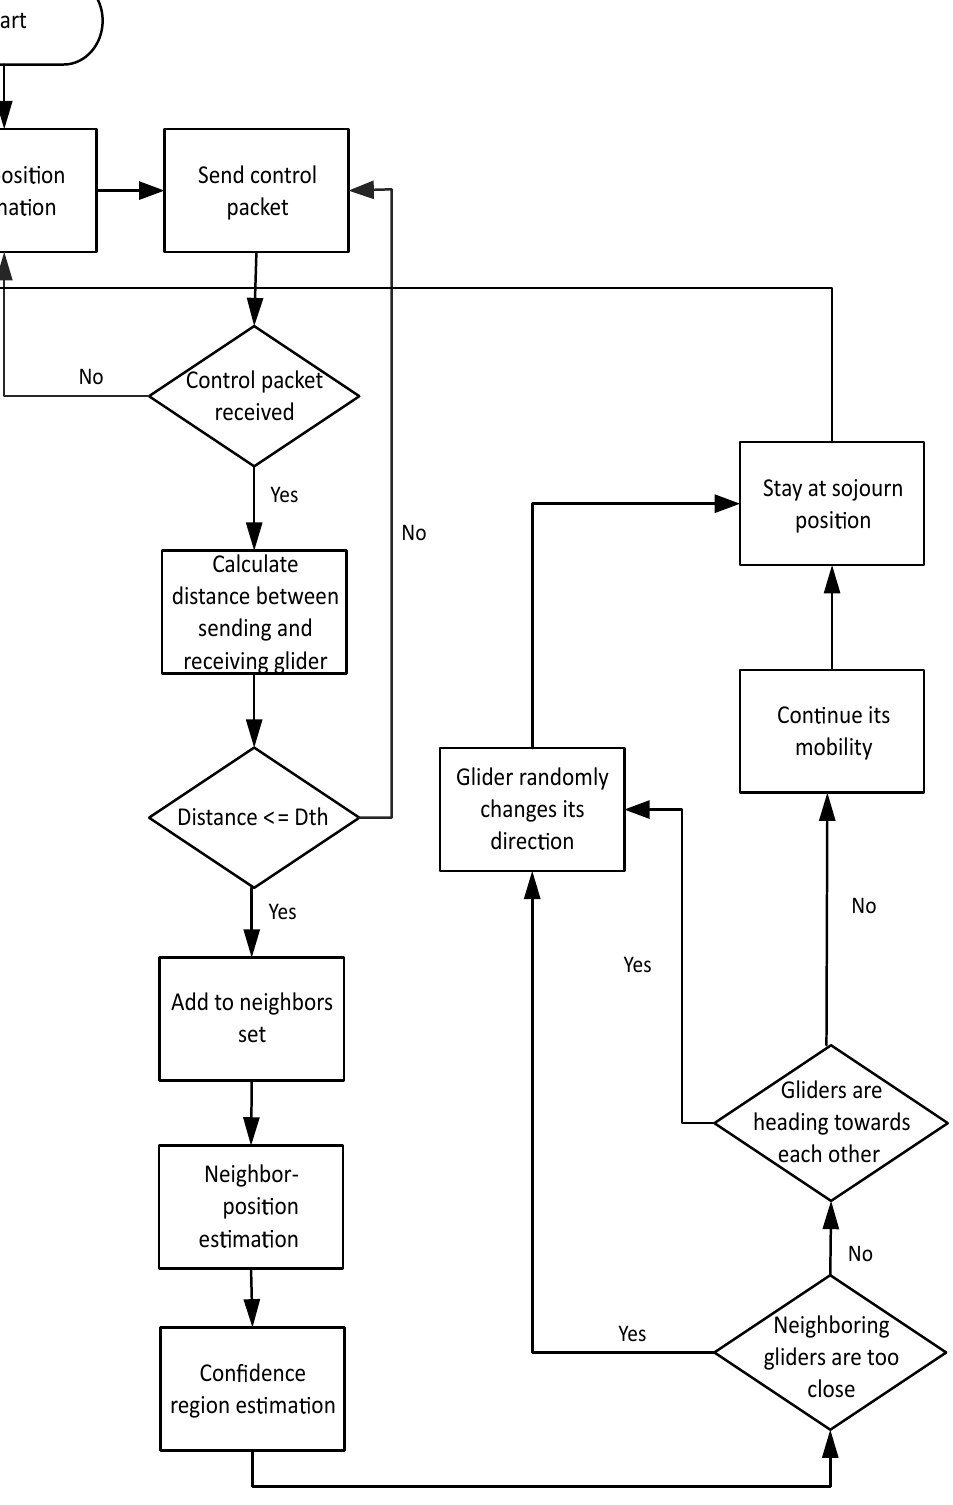
Figure 5. Mobility of gliders in PAMP and Co